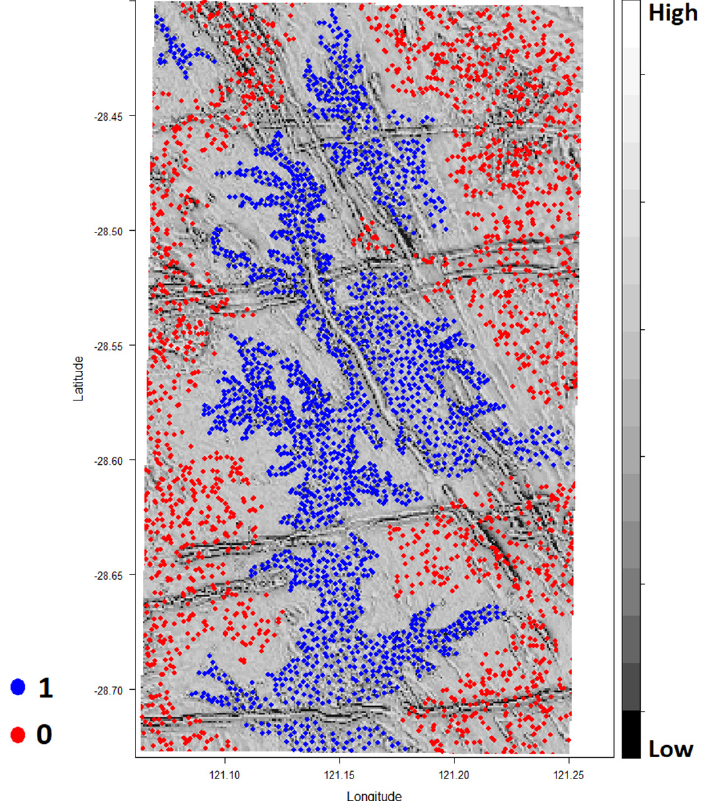
Figure 4. Processed high–resolution aeromagnetic layer for the Tarmoola area overlain by the training samples. Blue dots represent the positive samples from the area of interest, whereas the red dots represent the random negative samples from the rest of the area.